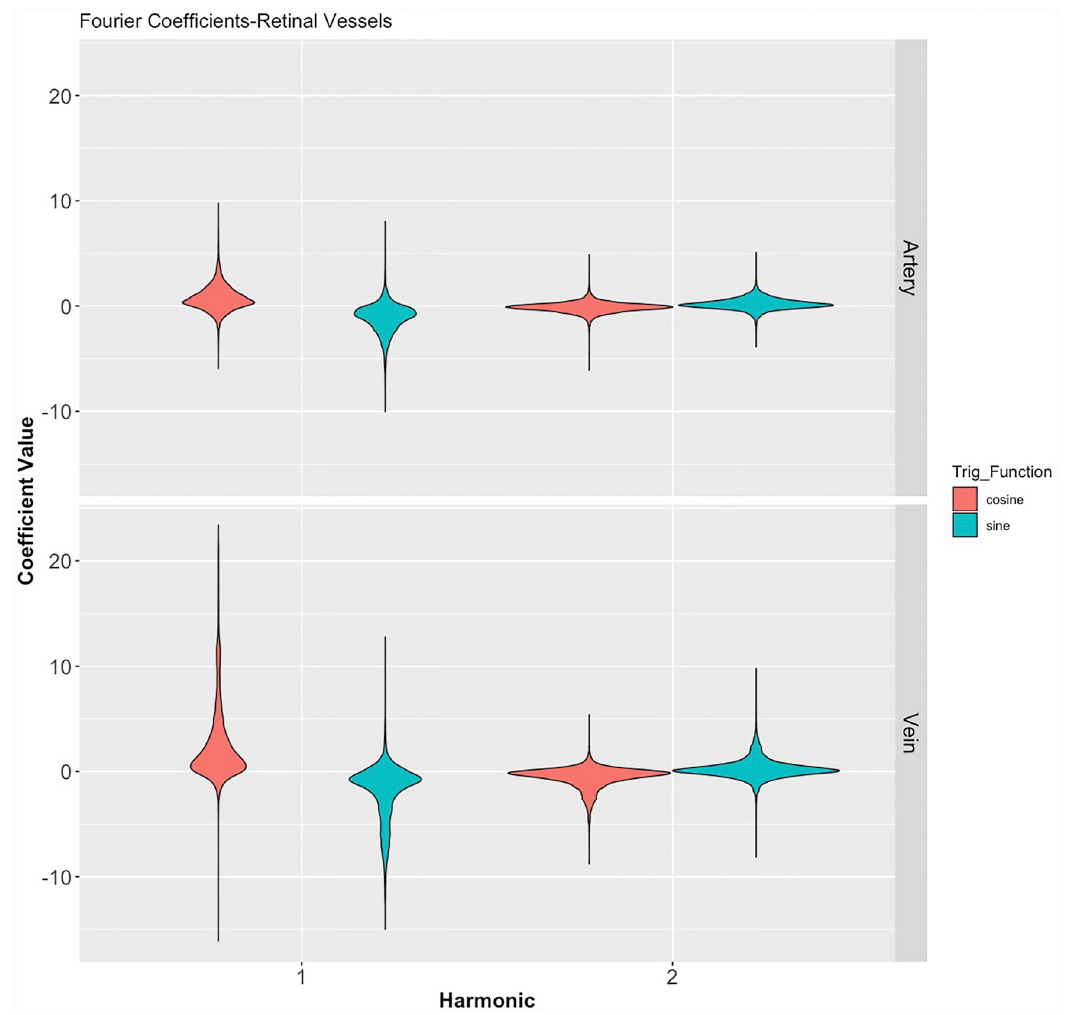
Fig 12. Violin plot of the distribution of the Fourier coefficients of the first and second Fourier harmonics in both vascular systems classified by trigonometric function. Demonstrating the wider range for both the cosine (a n ) and sine (b n ) coefficients in the veins, a narrower dispersion of values for the second Fourier harmonics and the disparate distribution, with displacement in the opposite direction across the axis of reference between the a n and b n coefficients in both vascular systems. Numeric values of the figure are outlined in Table